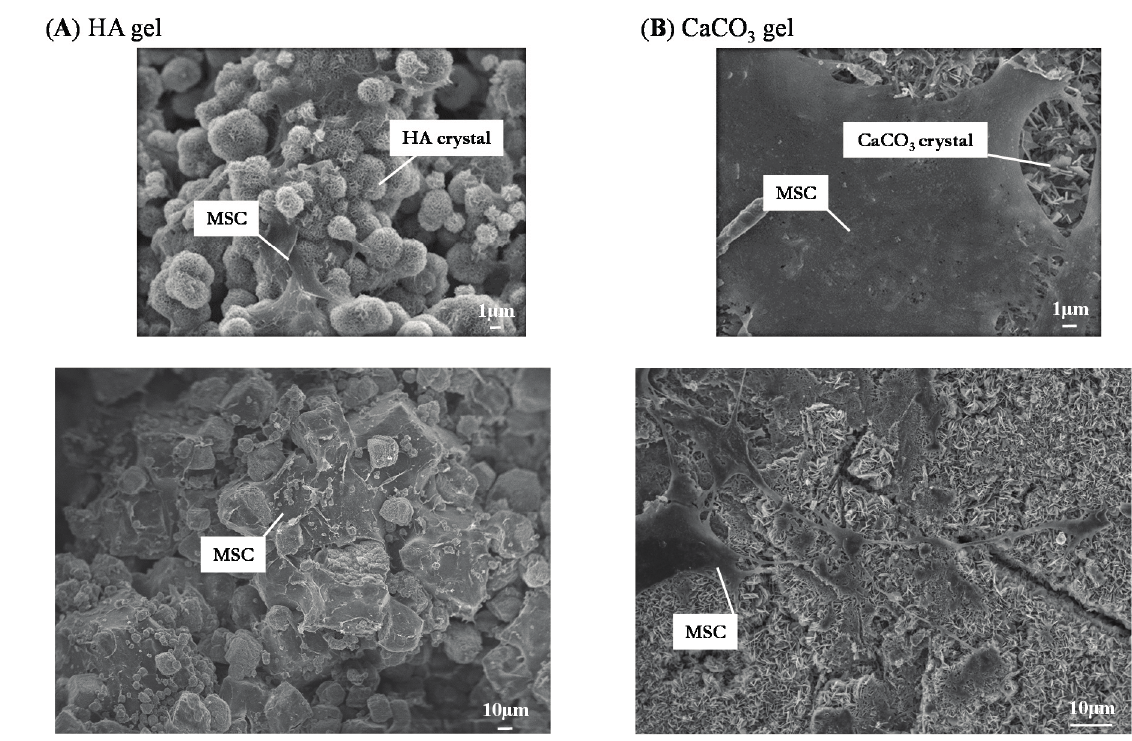
Figure 2. SEM images of MSCs cultured on HA/agarose and CaCO 3 /agarose gels for 21 days. ( A ) HA/agarose gel; ( B ) CaCO 3 /agarose